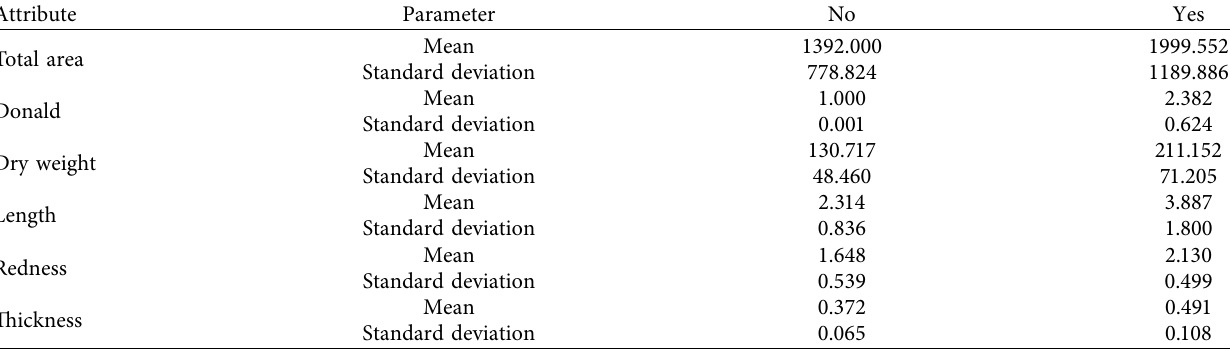
Table 2: Na¨ıve Bayes model.